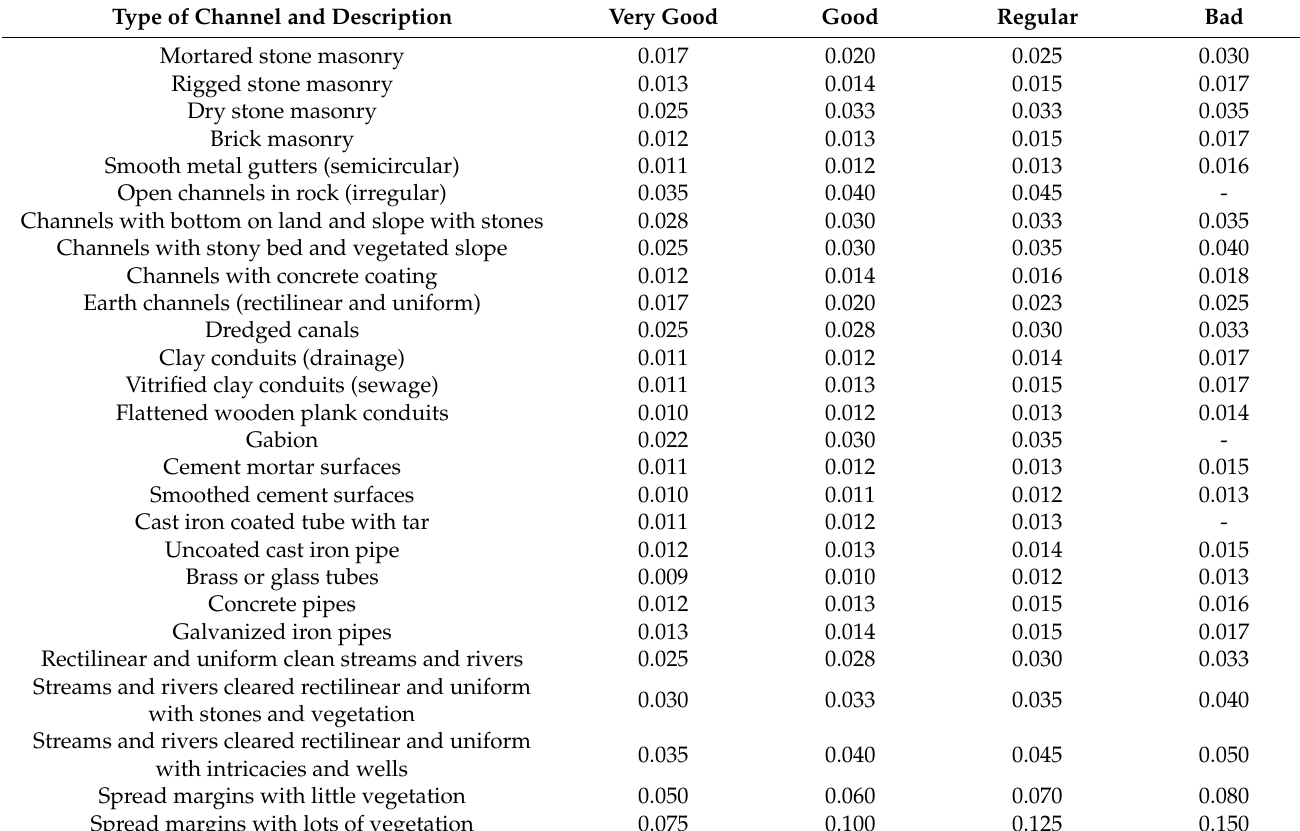
Table A1. Manning-Strickler roughness coefficients (Source: [31]).